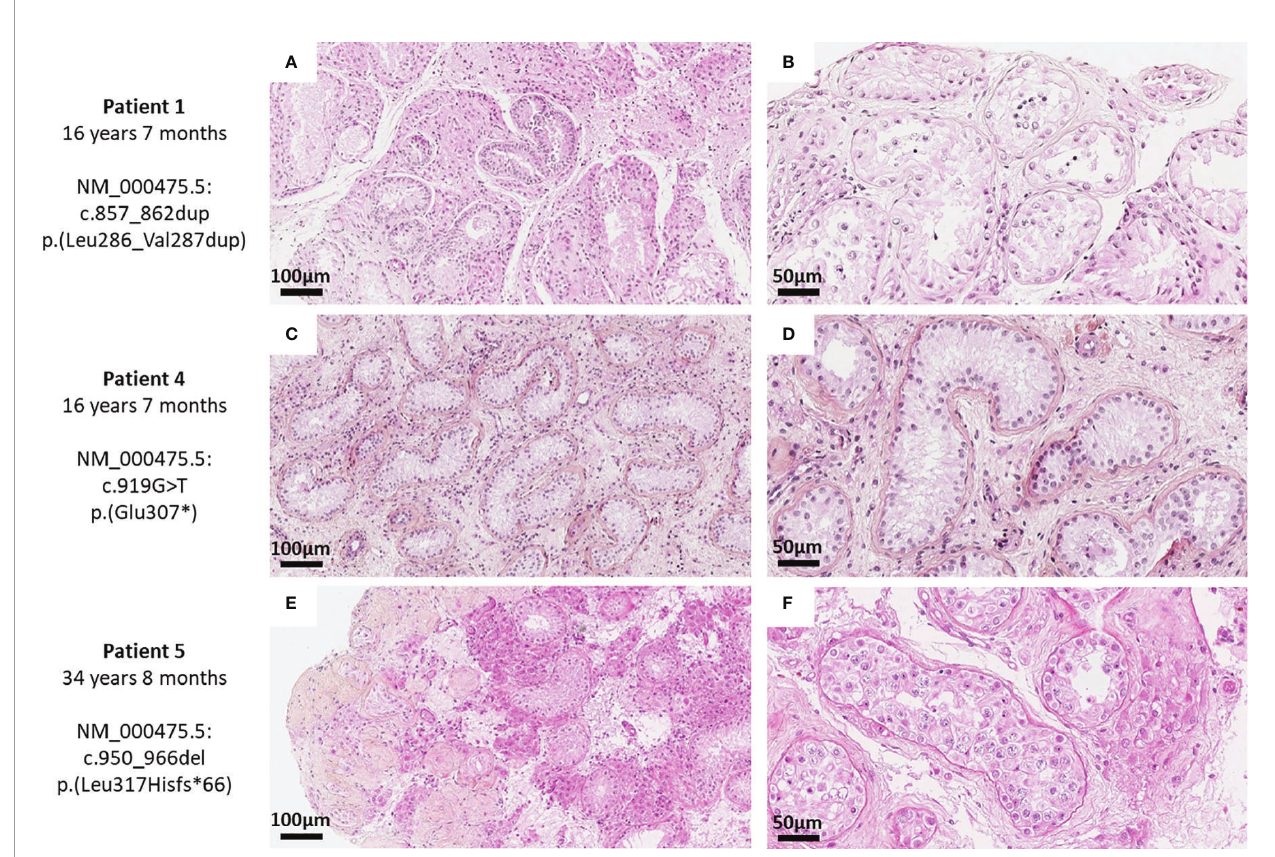
FIGURE 4 | Histological sections of testicular biopsies of patient 1 (A , B) , patient 4 (C , D) , and patient 5 (E, F) after gonadotropin treatment. Histological sections of testicular biopsies are shown at magni fi cations ×200 (A, C, E) and ×400 (B, D, F) after a hematoxylin – phloxin – saffron staining. All biopsies showed severe hypospermatogenesis with either Sertoli cell-only pro fi le (C , D) , histological mosaicism pro fi le with Leydig cell hyperplasia (A , E) , or maturation arrest at round spermatid stage (B) or spermatocyte stage (F)